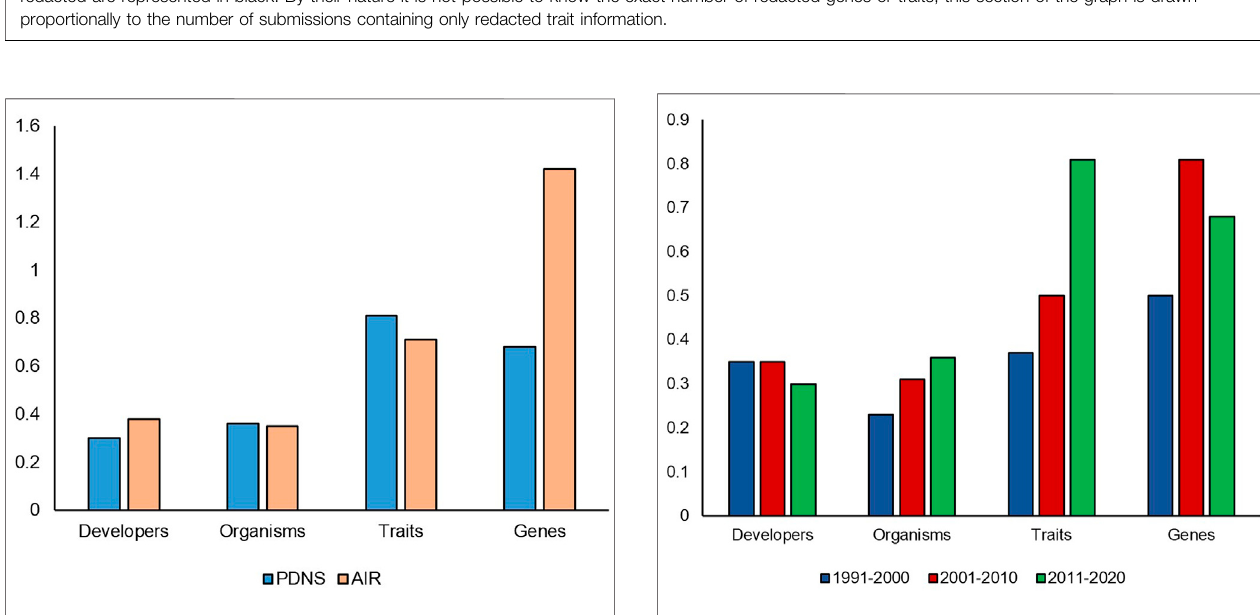
FIGURE 4 | PDNS diversity over time. Diversity ratios in each category were calculated for each 10 year timespan of the PDNS across all categories of